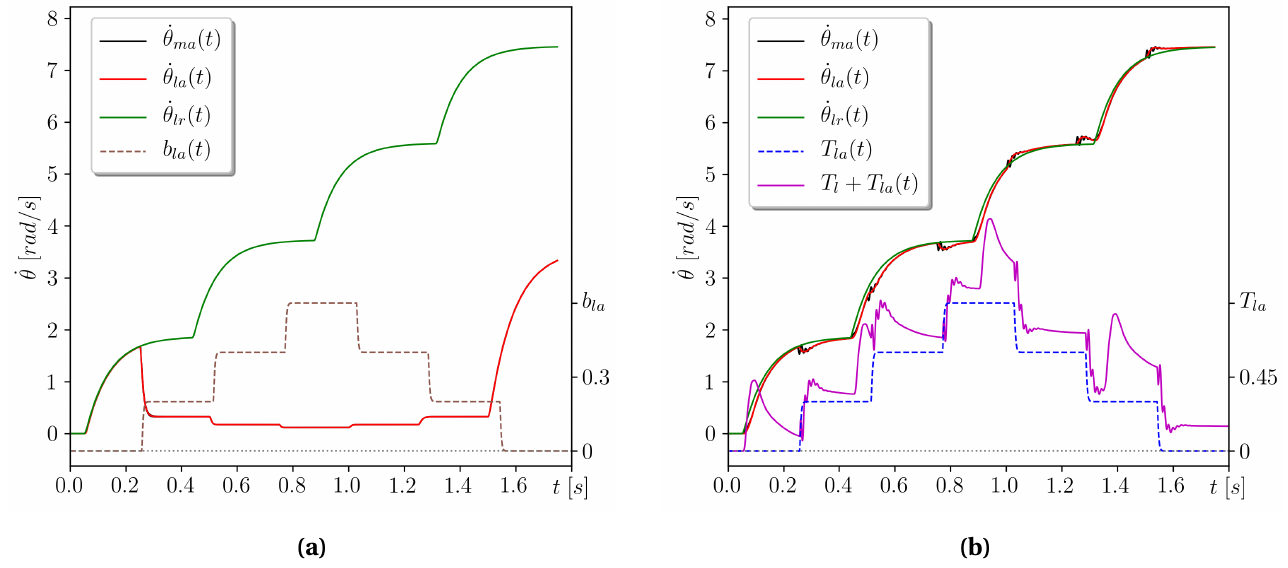
Figure 7. The closed-loop reference model control system response at the presence of: (a) b la ( t ); (b) T la ( t ) disturbance and a FOPID regulator (low frequency) – see case B in the block diagram in Figure 3.